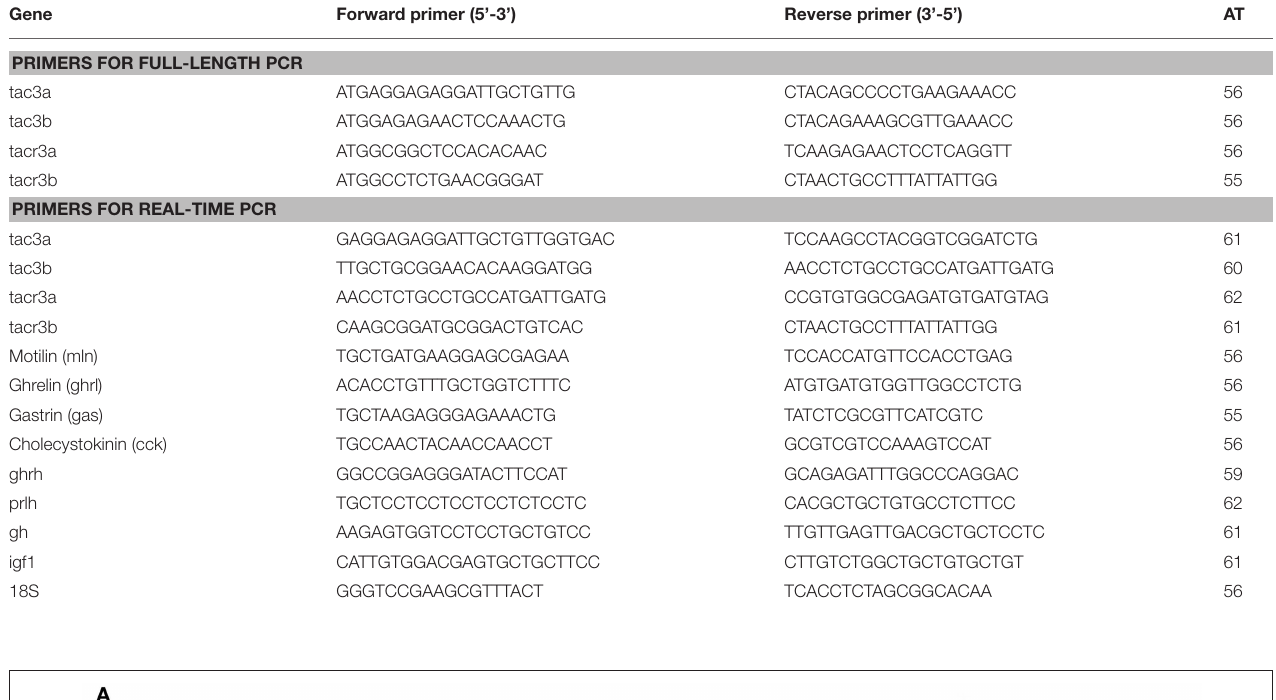
TABLE 1 | Primers used in the present study.